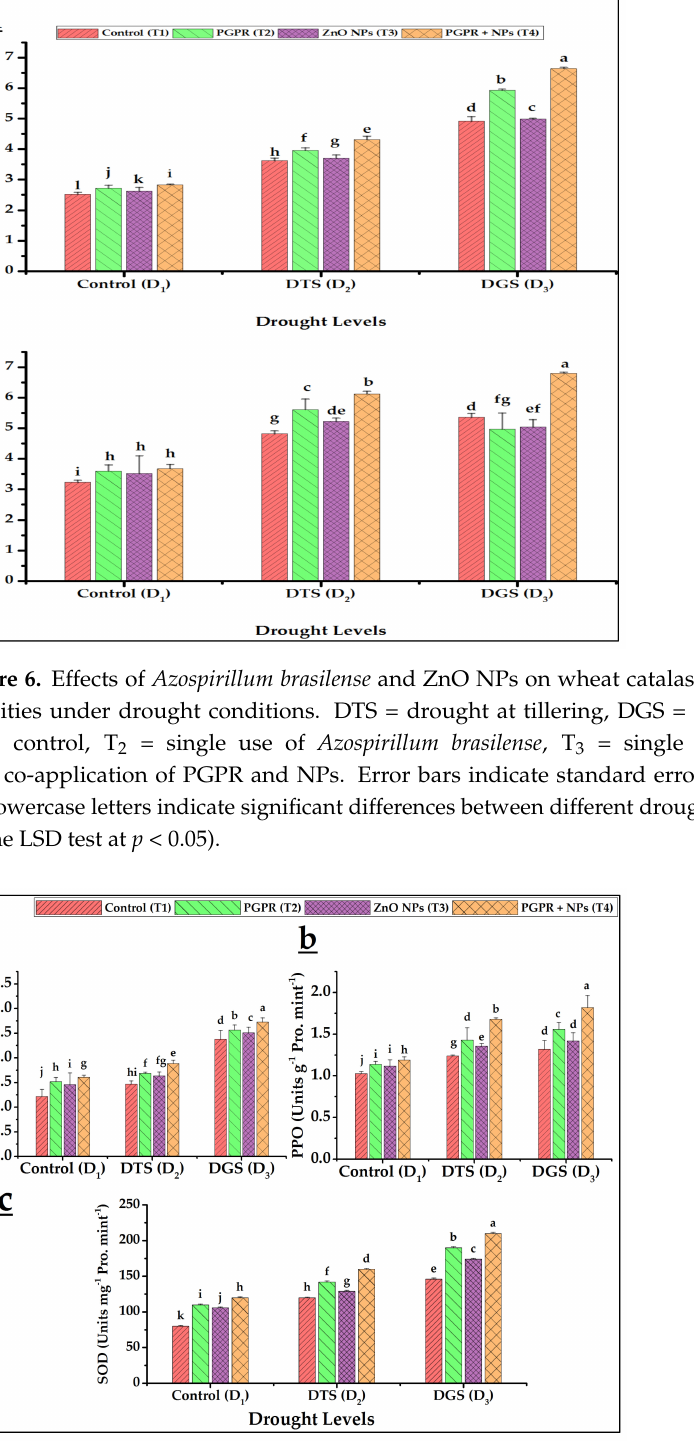
Figure 7. Effects of Azospirillum brasilense and ZnO NPs applications on ascorbate peroxidase ( a ), polyphenol oxidase ( b ), and superoxide dismutase ( c ) activities in wheat under drought. DTS = drought at tillering, DGS = drought at grain filling, T 1 = control, T 2 = single use of Azospirillum brasilense , T 3 = single use of ZnO NPs, and T 4 = co-application of PGPR and NPs. Error bars indicate standard error ( n = 3). (Note: Different lowercase letters indicate significant differences between different drought levels and treatments by the LSD test at p <